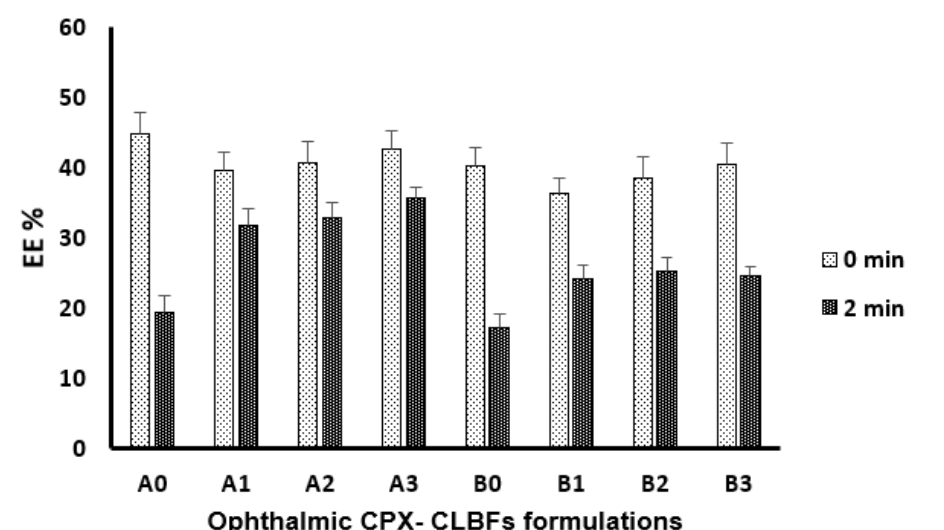
Figure 2. Effect of sonication time on percent entrapment efficiency (EE%) of ophthalmic CPX-CLBFs (mean ± SD, n = 3.0).